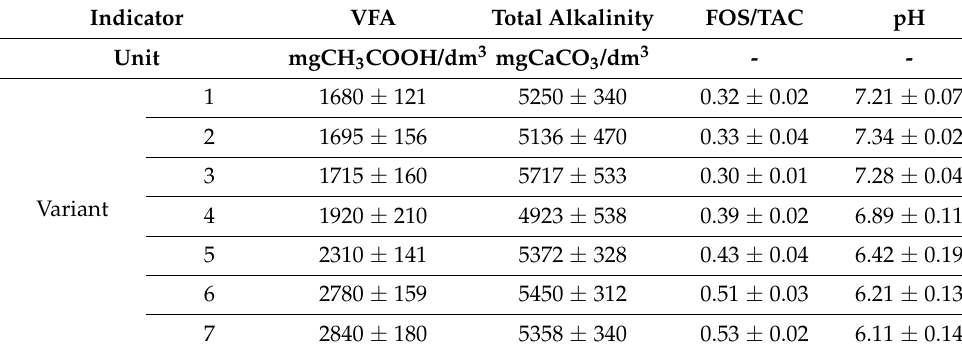
Table 6. VFAs, total alkalinity, FOS/TAC and pH in the digesters (by variant).